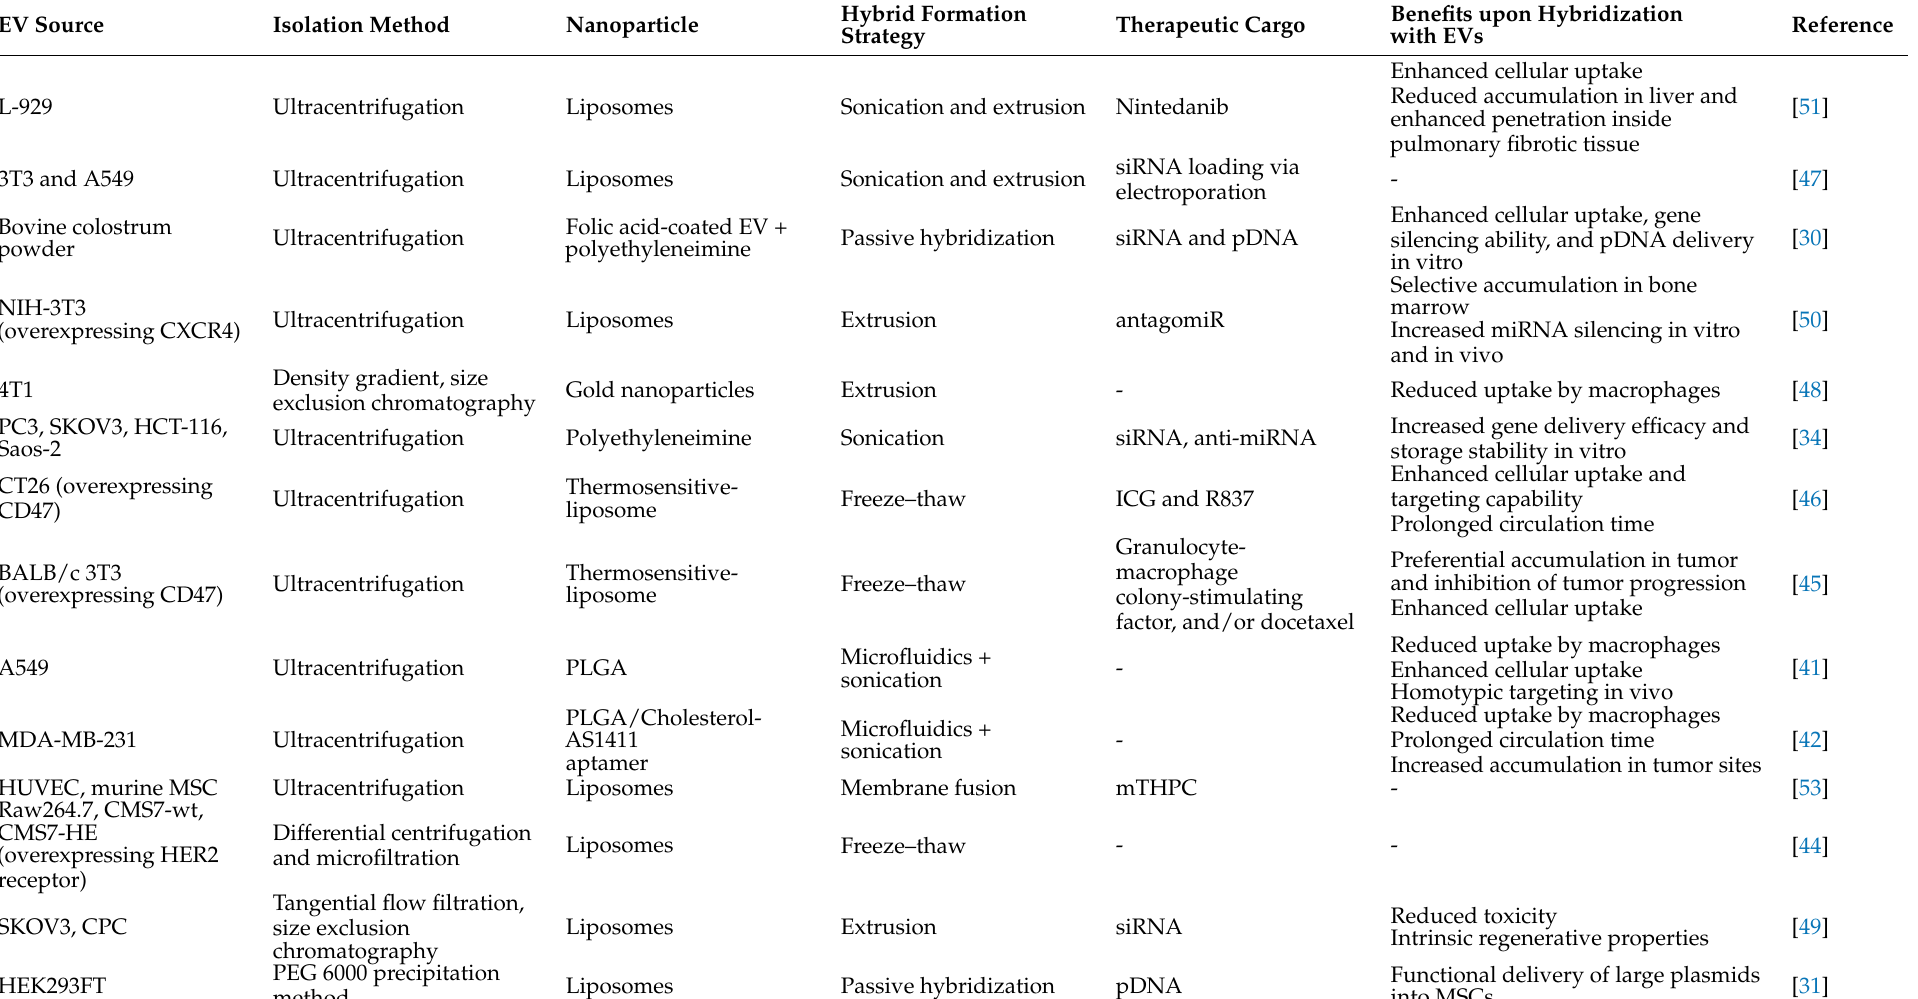
Table 1. Overview of various strategies employed to produce EV-based hybrid systems as well as the attributed